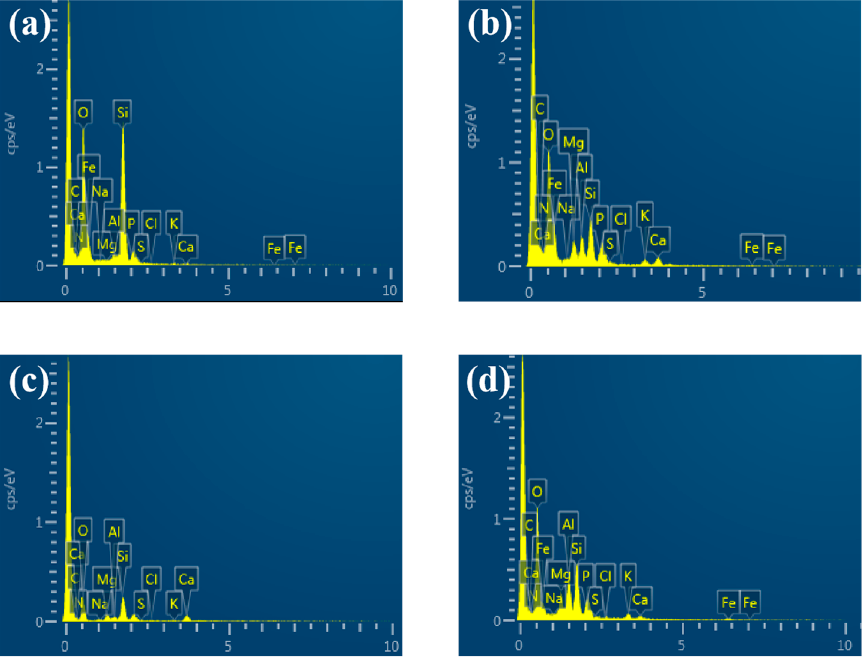
Figure 3. EDS characterization of dust particles from ( a ) bare land, ( b ) stock dump, ( c ) construction, and ( d ) road dust. Table 4. Elemental composition of particles from the four fugitive dust sources.